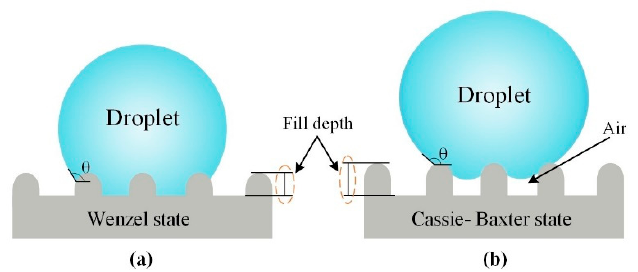
Figure 11. Droplet wettability state at different filling depths of micro-structures: ( a ) Wenzel state; ( b ) Cassie-Baxter state.